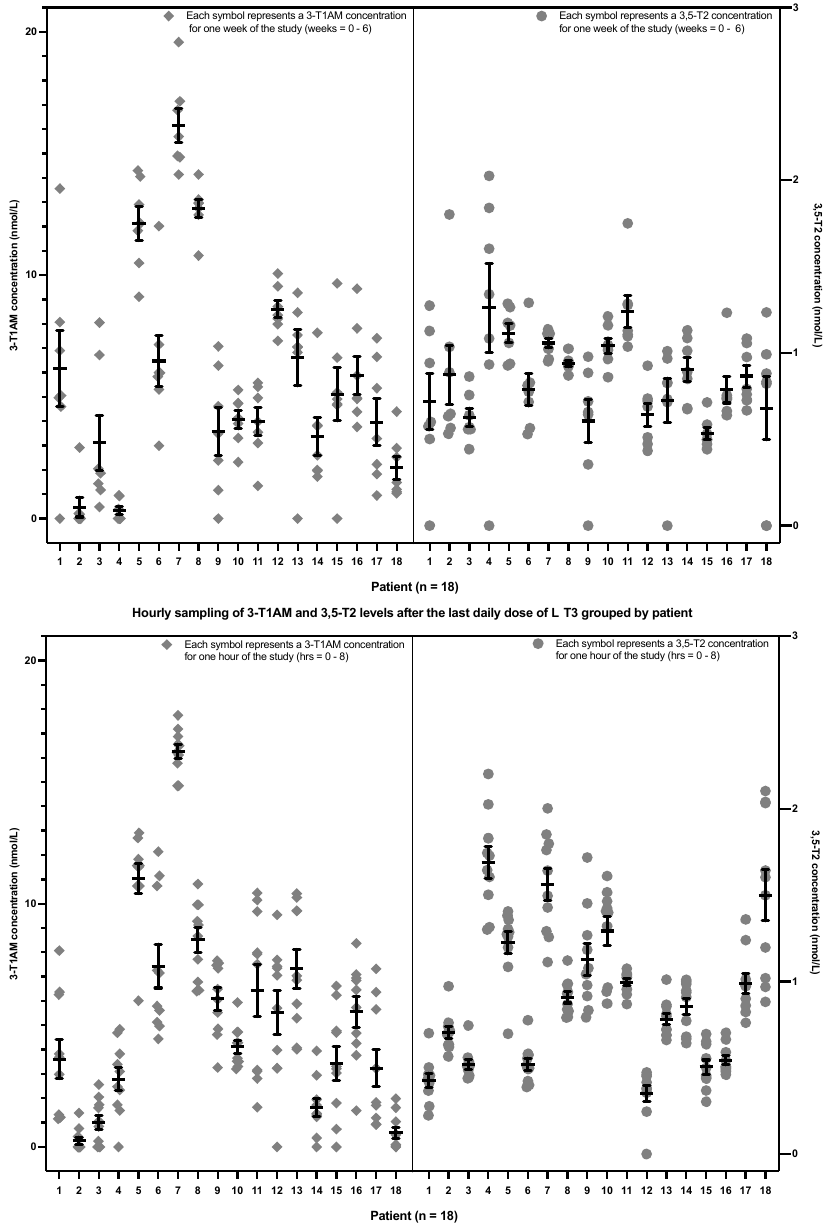
Figure 5. 3,5-T2 and 3-T1AM concentrations from the weekly (upper section) and hourly sampling (lower section) grouped by the 18 individual patients with hypothyroidism (The lower limit of detection is 0.2 nmol/L for 3,5-T2 and approximately 5 nmol/L for 3-T1AM. 3,5-T2: 3,5-diiodothyronine, 3-T1AM: 3-iodothyronamine, LT3: liothyronine).